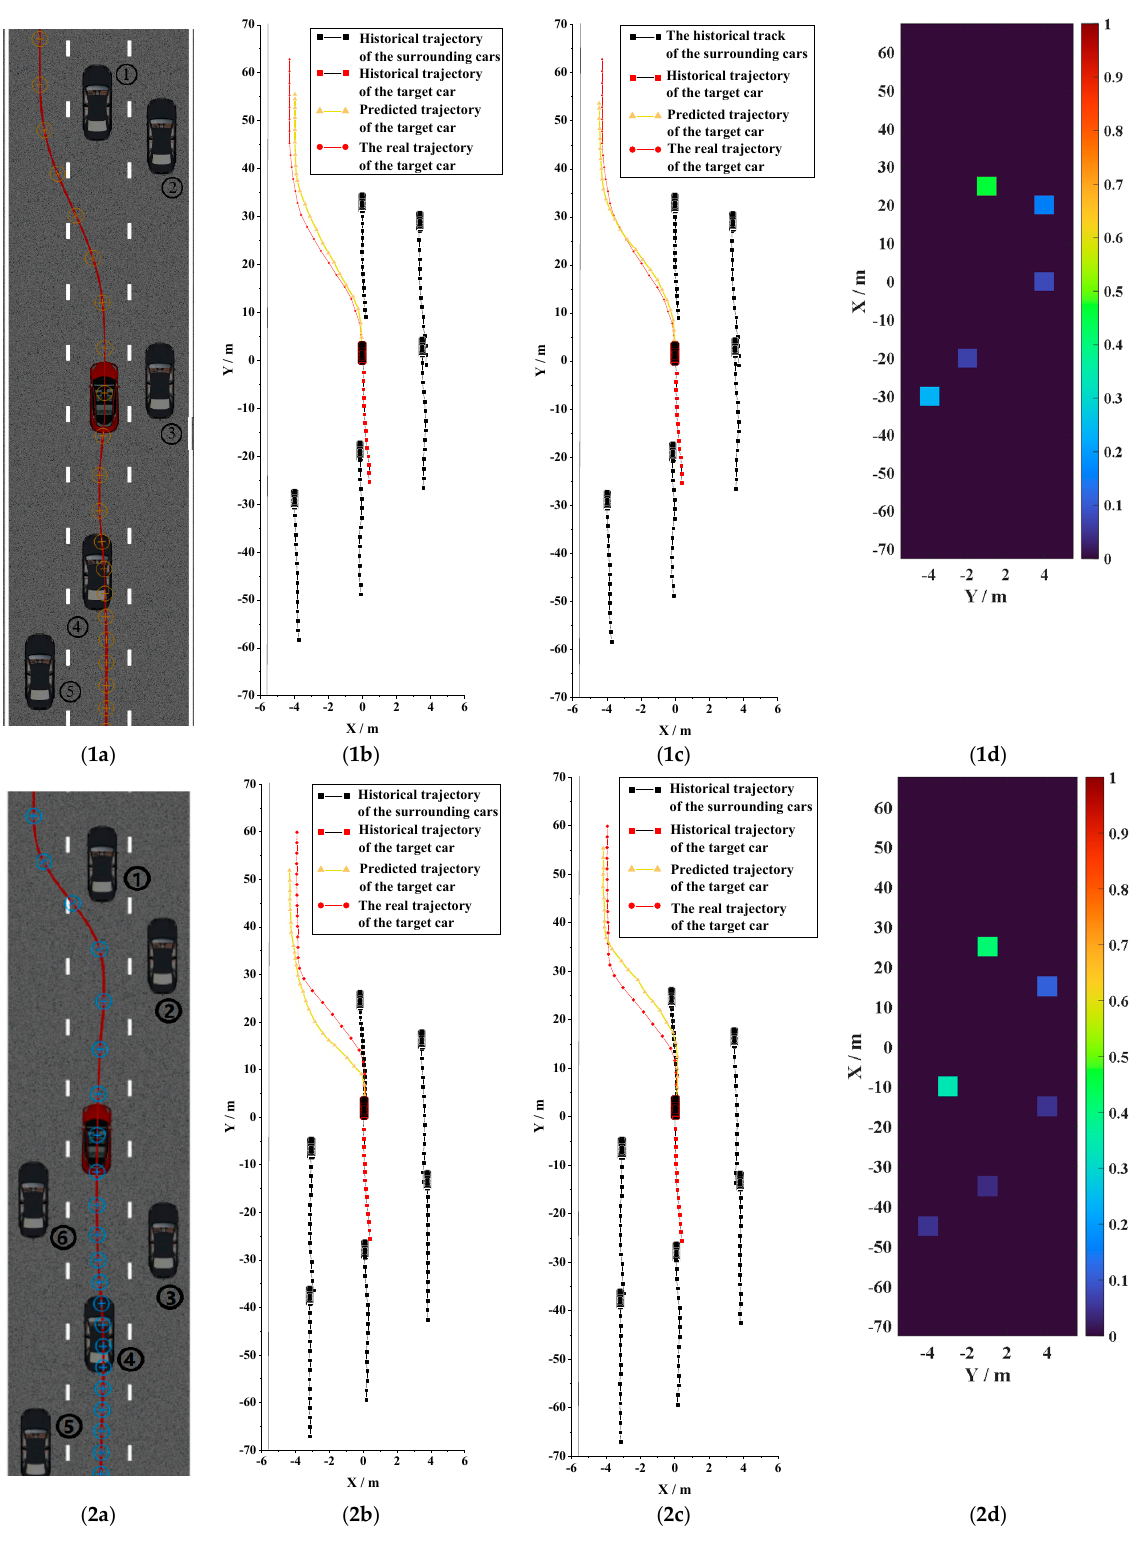
Figure 8. Comparison of model predicted trajectory results in joint simulation: ( 1a , 2a ) shows the target vehicle lane change trajectory prediction under two different traffic conditions; ( 1b , 2b ) shows the predicted trajectory distribution of the CS-LSTM model; ( 1c , 2c ) shows the predicted trajectory dis- tribution of the RA-LSTM model; ( 1d , 2d ) shows the calculated weight tensor in RA-LSTM, visualizing the weight distribution of the attention influence of surrounding